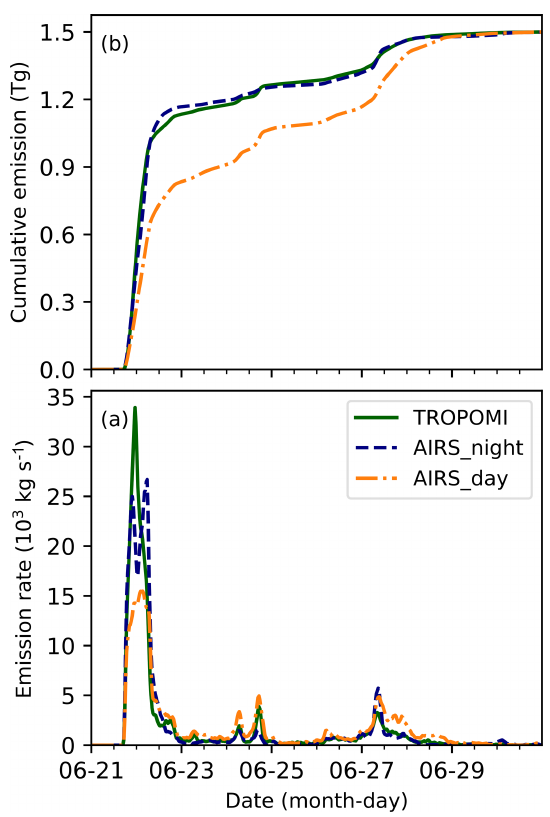
Figure 5. Temporal change of the Raikoke SO 2 injections recon- structed based on the TROPOMI SO 2 product (green line) and AIRS SO 2 product during nighttime (dashed blue line) and daytime (dashed–dotted orange line): (a) vertically integrated SO 2 injection rate and (b) accumulated SO 2 mass.